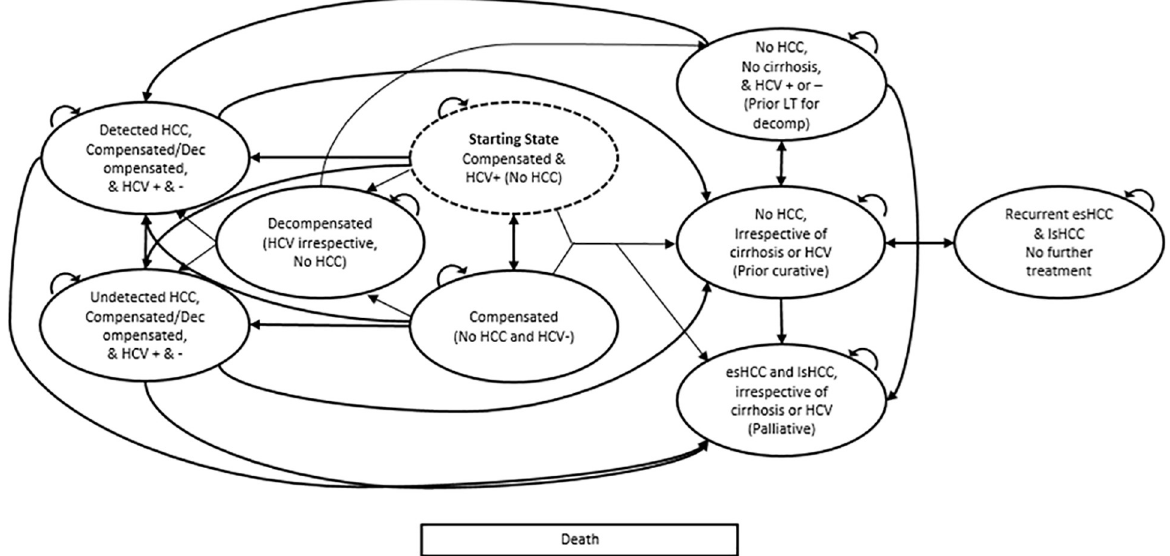
Fig 1. HCV/HCC progression model. esHCC = early stage hepatocellular cancer, HCC = hepatocellular cancer, HCV = hepatitis C virus, lsHCC = late stage hepatocellular cancer. “HCV irrespective” = applies to both HCV-positive and HCV-negative patients. The diagram shows a condensed version of the model. The full model includes 27 mutually exclusive health states based on HCV status, presence of decompensation, cancer stage, detected HCC, HCC cure after treatment, treatment type, cancer recurrence, and death. Ovals represent health states and arrows state transitions. Death is possible in each state.